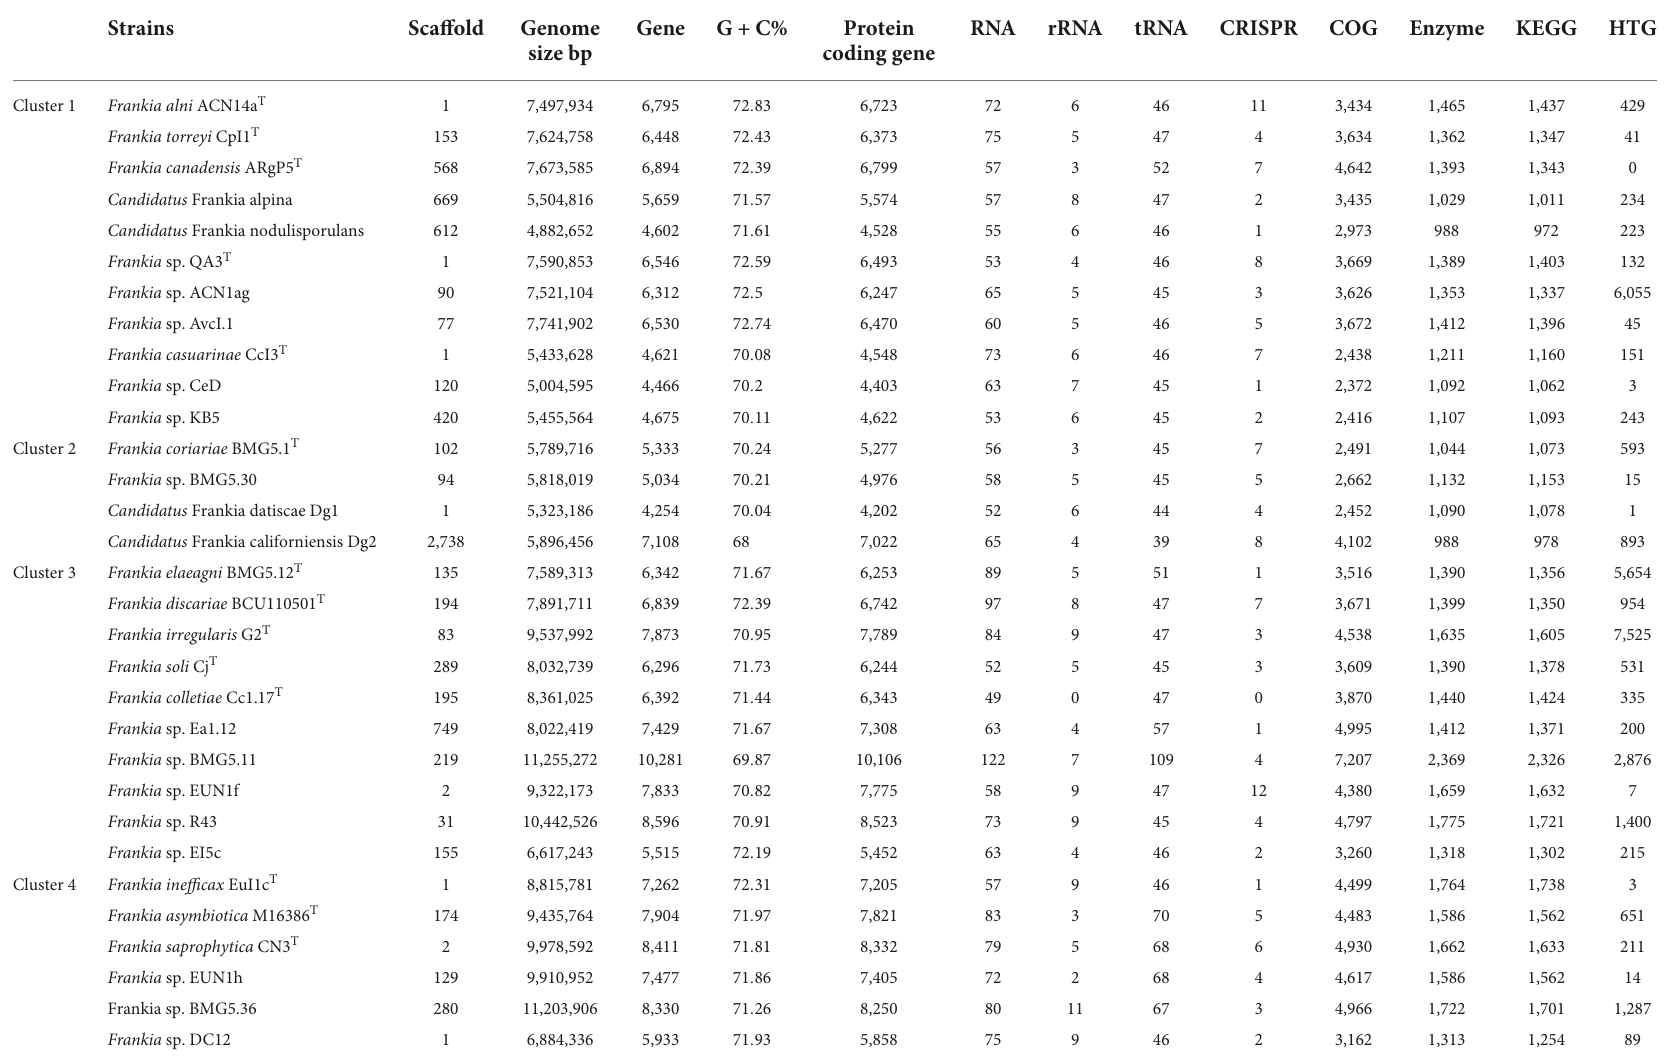
Gene G + C% Protein RNA rRNA tRNA CRISPR COG Enzyme KEGG HTG size bp coding gene